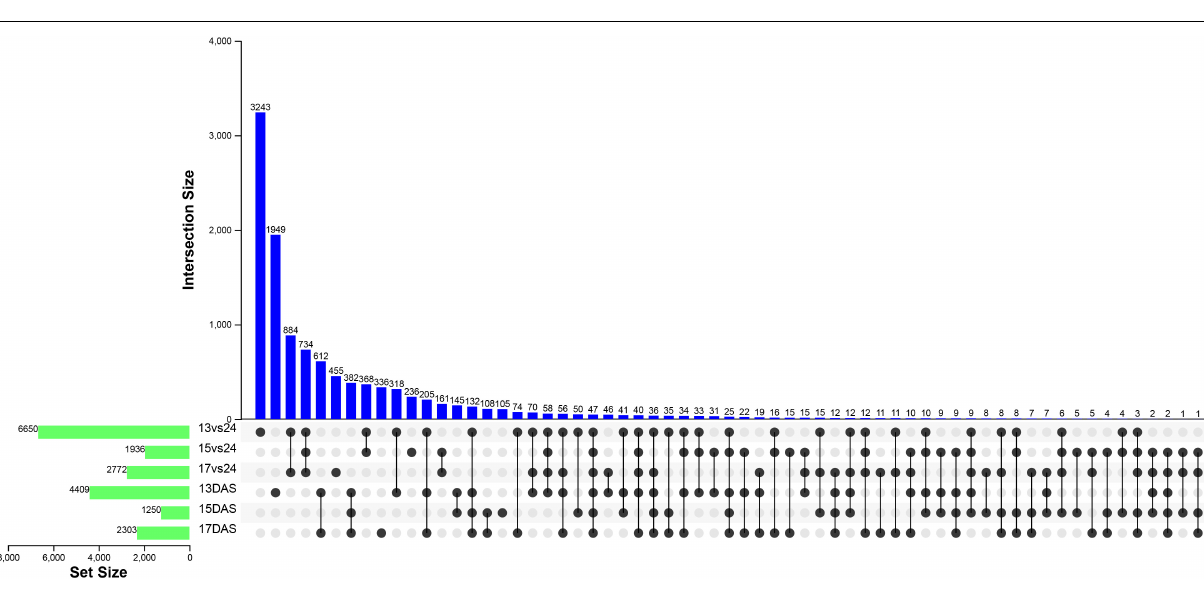
FIGURE 2 | Upset plot of interactions between transcription and alternative splicing regulation of differentially expressed genes. 13vs24, 15vs24, and 17vs24 and 13DAS, 15DAS, and 17DAS represented the number of differentially expressed genes at the transcription and alternative splicing regulation,